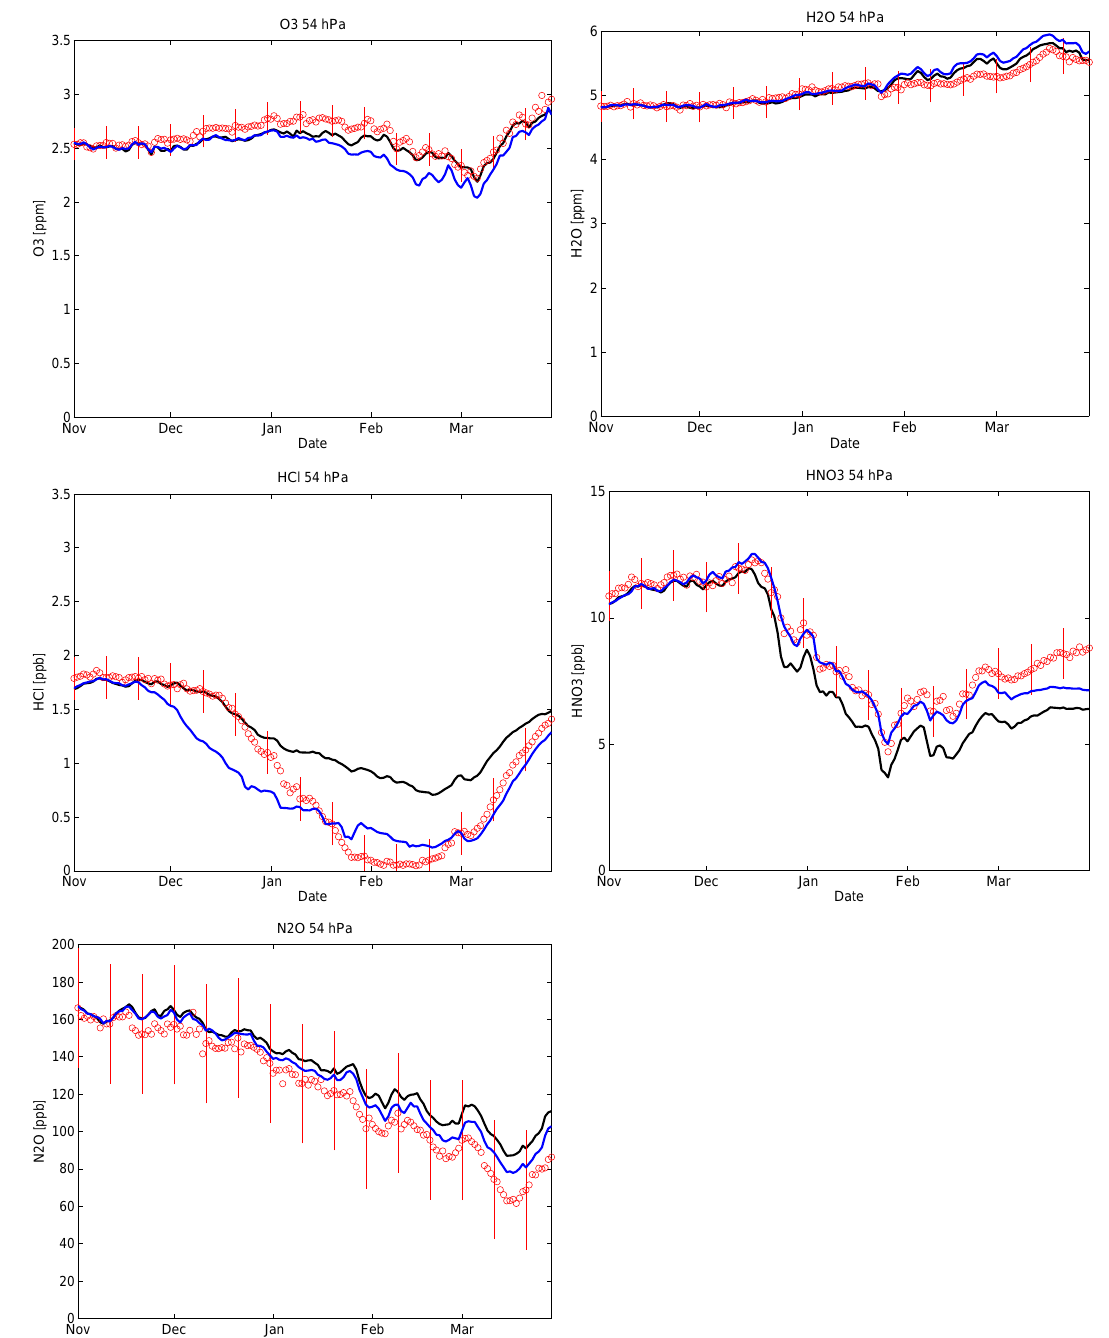
Figure 21. Vortex-averaged mixing ratios of O 3 , H 2 O, HCl, HNO 3 and N 2 O for the Arctic winter 2004–2005 at 54hPa. The red dots show MLS satellite measurements (version 3, with bars showing the accuracy), the blue lines show the ATLAS runs used in this paper and the black line shows the original runs which are not empirically corrected for the HCl discrepancy.